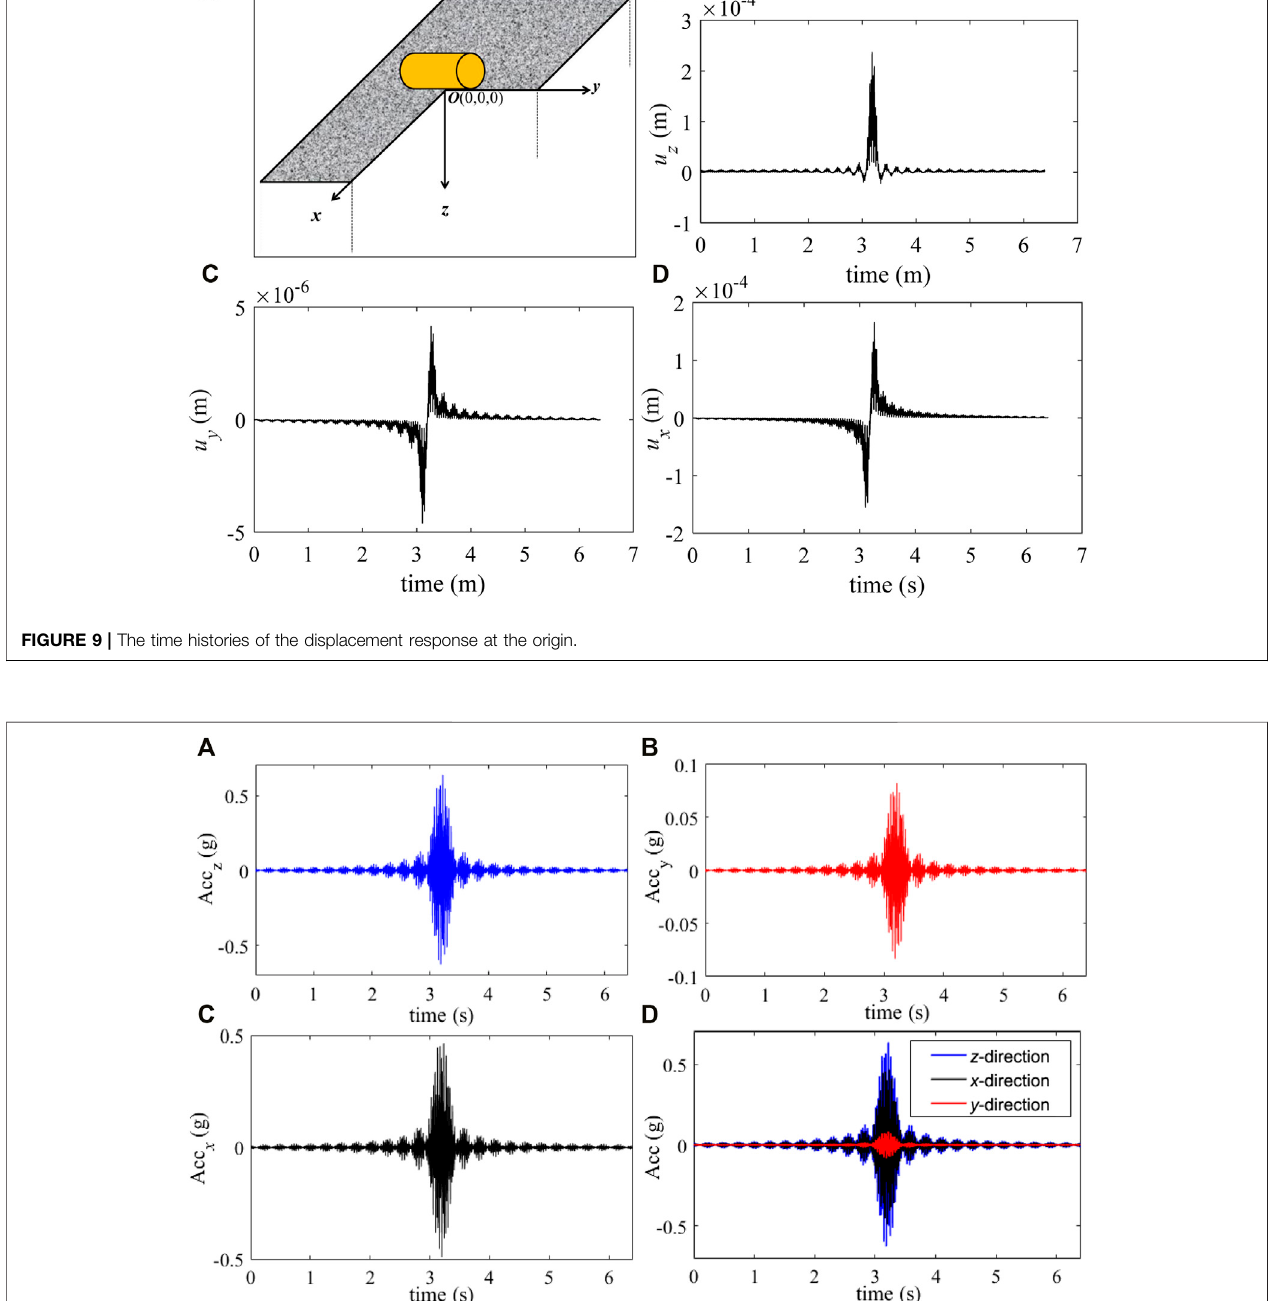
FIGURE 10 | Acceleration of point O in the rolling process.